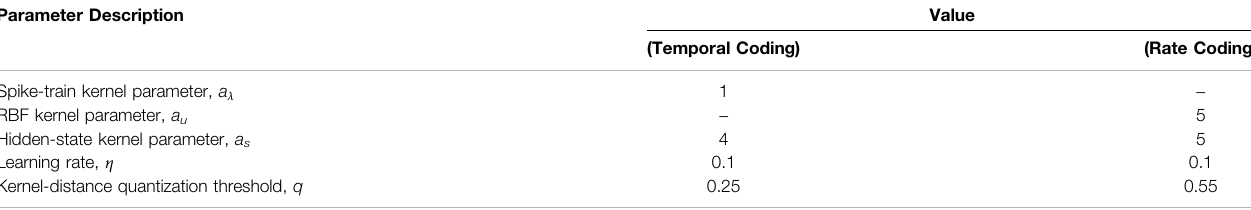
TABLE 2 | KAARMA parameters. Parameter Description